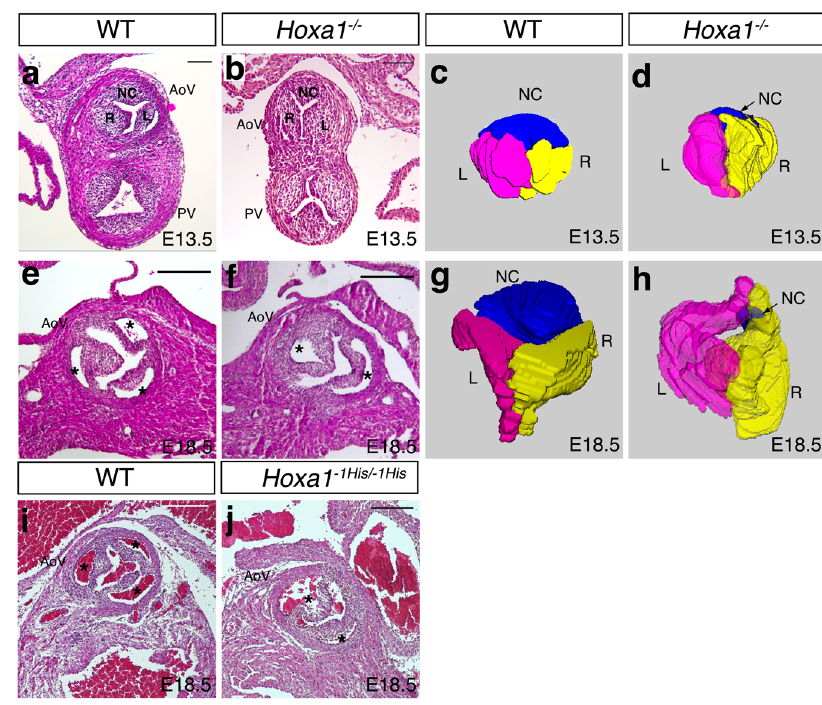
Fig. 4 | Hoxa1 knock-out and Hoxa1 − 1His knock-in mice display bicuspid aortic valve. a , b Hematoxylin and eosin (H&E) staining images showing representative transversal section of wild-type (WT) and Hoxa1 − / − out fl ow tract at E13.5. Repre- sentative pictures from 3 independent hearts of each genotype. c , d Three- dimensional(3D)reconstructionsofhistologicalimagesatE13.5.Aslightdifference between WT ( c ) and Hoxa1 − / − ( d ) aortic valve (AoV) structure is observed. Indeed, the non-coronary lea fl et (NC) seems smaller in Hoxa1 − / − when compared to wild- type embryos. e , f Cross-sectional H&E images through the aortic valve of WT ( e ) and Hoxa1 − / − ( f ) embryos at E18.5. Representative pictures from 3 independent hearts of each genotype. Normal valve with three lea fl ets (asterisks) is observed in